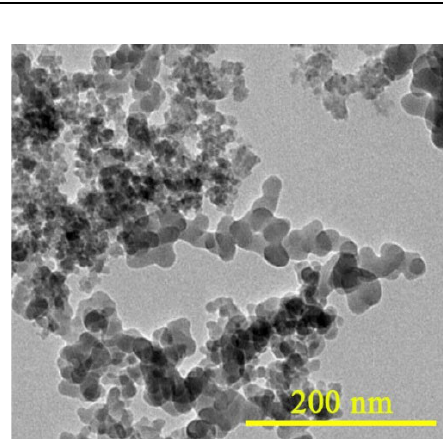
Figure 1. TEM image of NS (From the merchant).